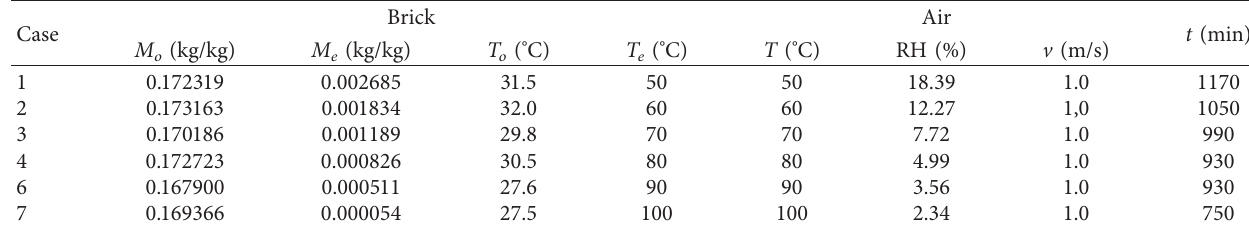
Table 2: Values used in numerical simulations with a ceramic brick (experimental conditions).